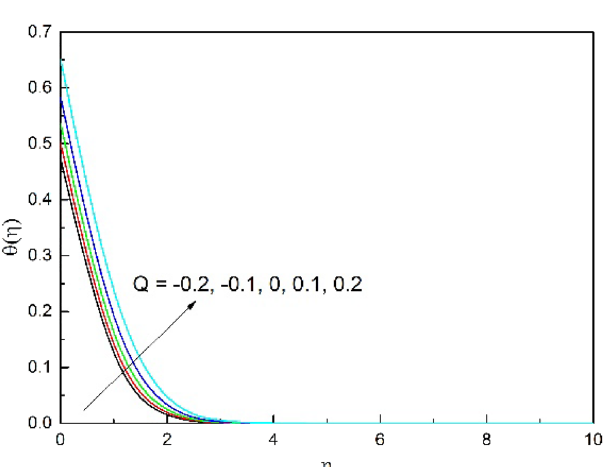
Figure 4. Q on θ(η) .